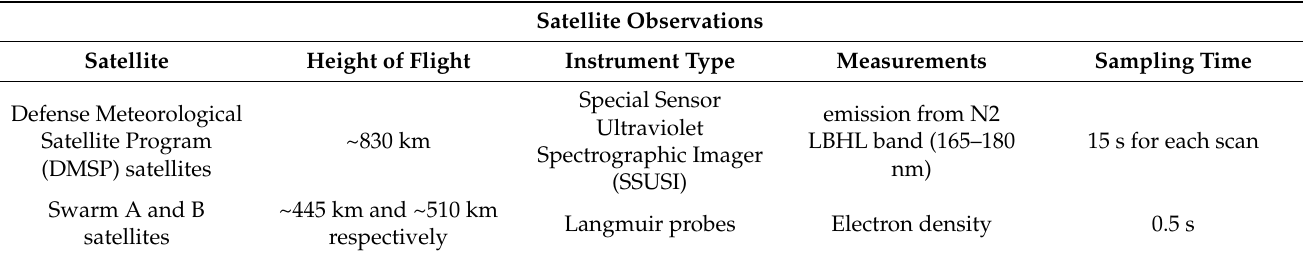
Table 2. Satellite, height of flight, instrument type, measurements and sampling time of the space-based observations used in this study.